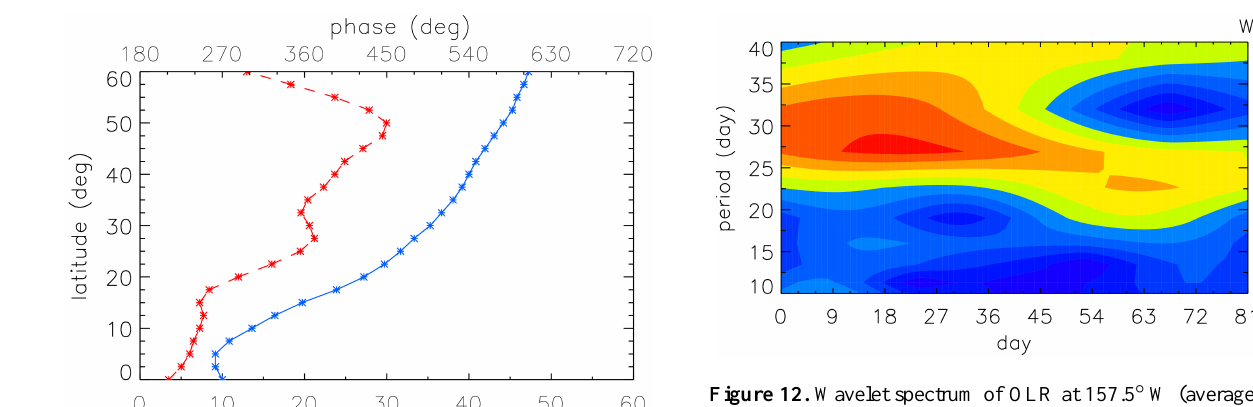
Figure 12. Wavelet spectrum of OLR at 157.5 ◦ W (averaged over 5–20 ◦ N) from NCEP/NCAR-interpolated OLR